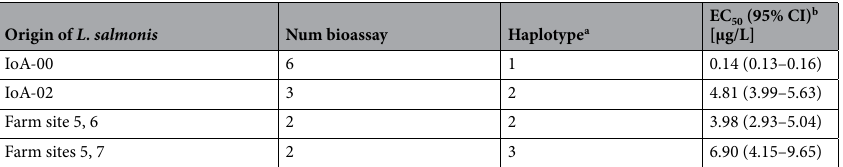
Table 3. Deltamethrin susceptibility and mitochondrial haplotype of L. salmonis copepodid larvae. Each bioassay was performed with the copepodid descendants of one female salmon louse. L. salmonis originated from the laboratory strains IoA-00 and IoA-02, or Scottish aquaculture production sites. Bioassays involved exposure (24 h) to deltamethrin and rating of copepodids as normal or affected. Haplotypes were established based on the genotyping of 10 individuals per bioassay. a For definition of haplotypes, see Table 1. b Raw data used to derive EC 50 values are provided in Supplementary Data S1.